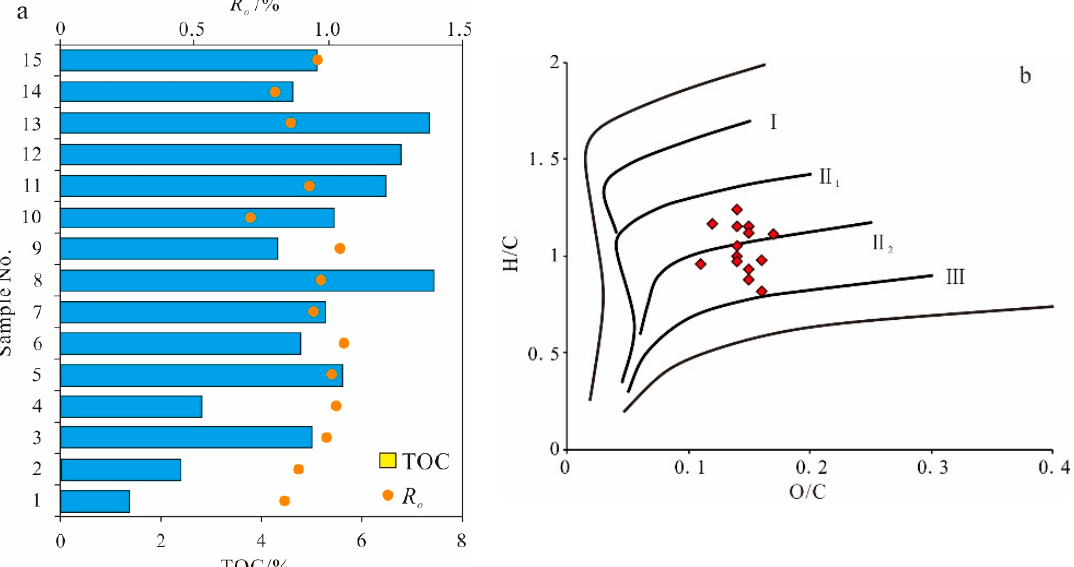
Figure 1. Organic geochemistry features of the Yanchang shale samples. ( a ) Total organic carbon (TOC) content and R o values of the studied shale samples; ( b ) Organic matter type determined by D. W. Van Krevelen chart [59].